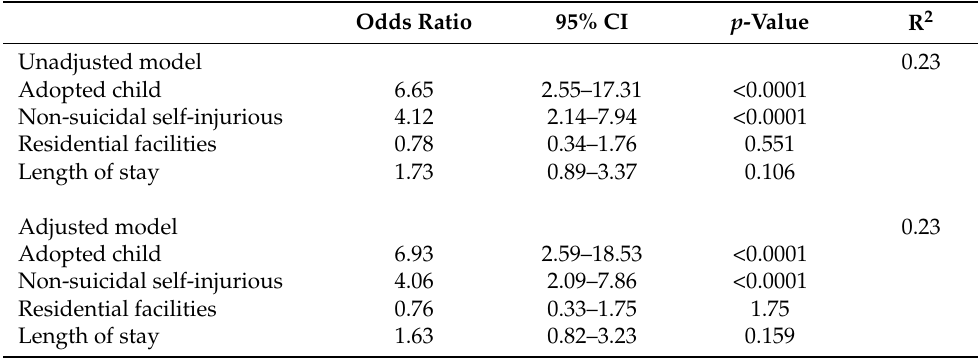
Table 3. First logistic regression model predicting Revolving Door with the reference category for each variable considered.